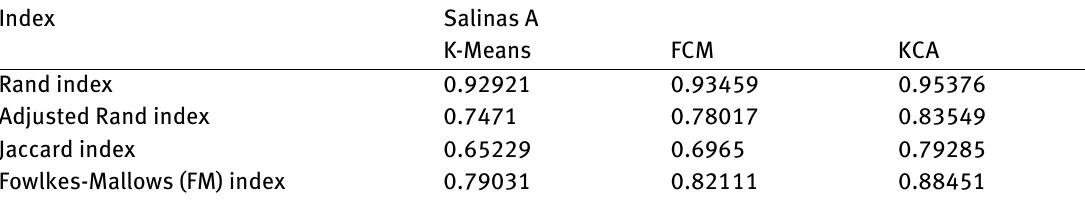
Table 8: External validity indices values of the classified remote sensing image provided by K-Means, FCM and KCA algorithms